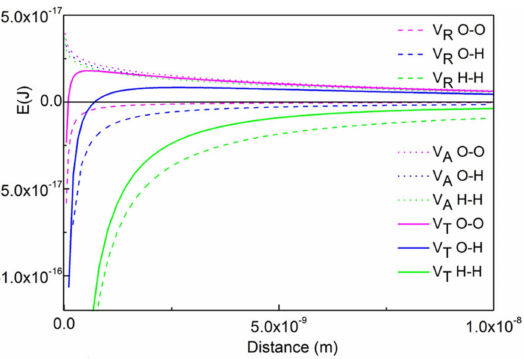
Figure 11. The relationship between interaction energy of fine impurities and particles distances at pH 7.